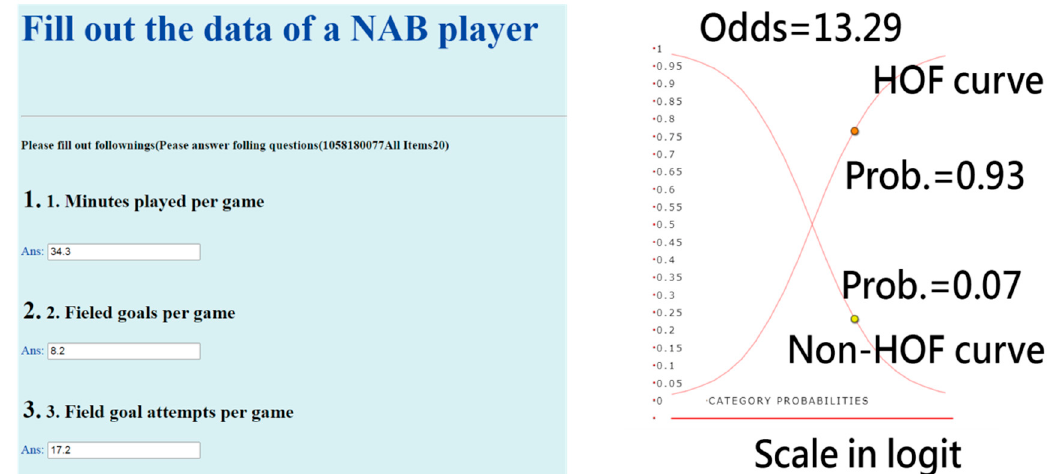
Figure 5. Snapshot of the NIQJ app on a smartphone.